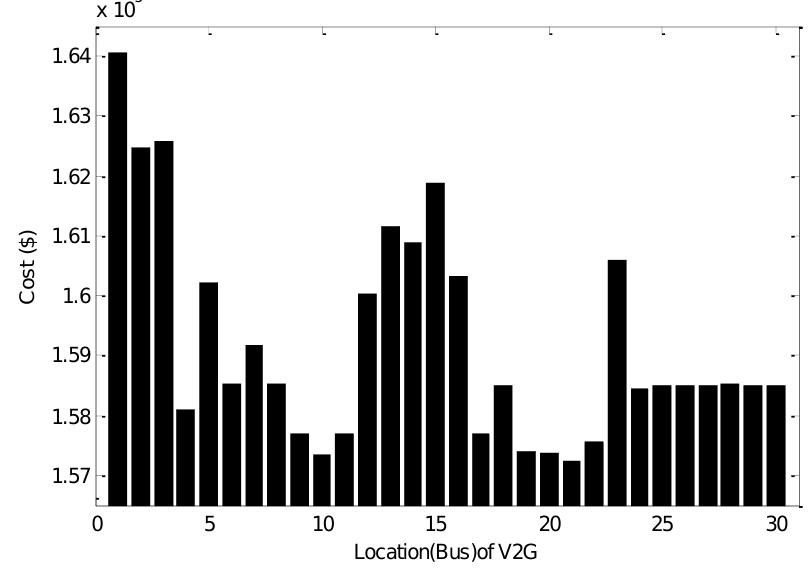
Figure 16. The total operating cost versus different locations of the charging station.